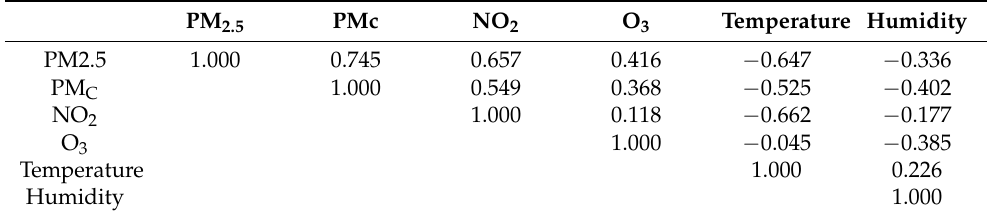
Table 3. Pearson’s correlation coefficients for air pollutants and weather conditions during the study period.